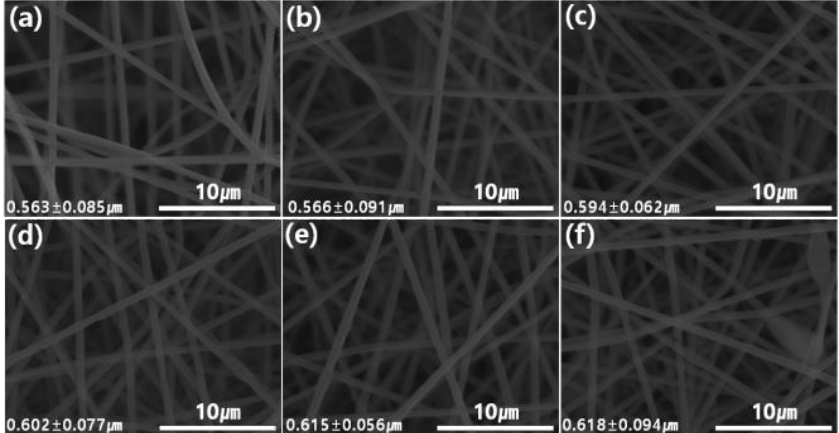
Figure 5. Scanning electron microscopy (SEM) images of polyacrylonitrile (PAN), graphene oxide modified by polydiallyldimethylammonium chloride/polyacrylonitrile (GP/PAN) hybrid nanofiber membranes; ( a ) PAN nanofiber membrane, ( b ) GP01PAN, ( c ) GP02PAN, ( d ) GP03PAN, ( e ) GP04PAN, ( f ) GP10PAN.